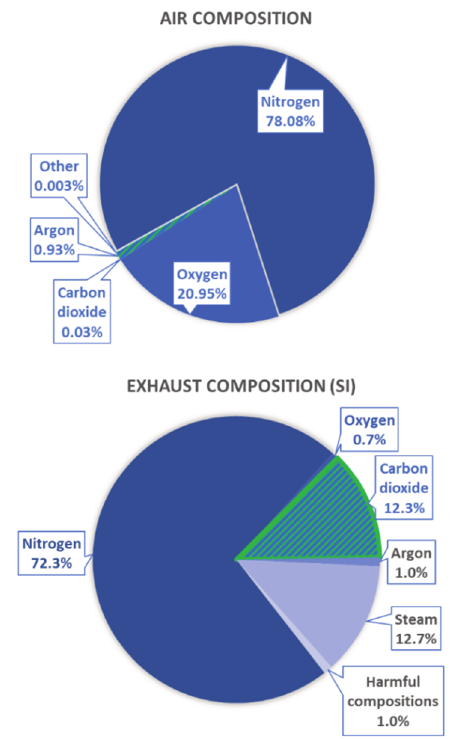
Fig. 11. The composition of air and exhaust gases in the SI engine (with a catalytic converter)